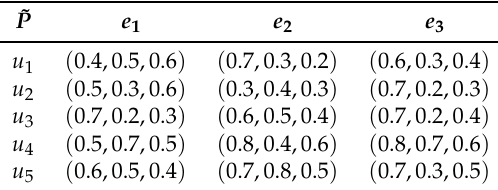
Table 7. Neutrosophic soft set ( ˜ P , M )